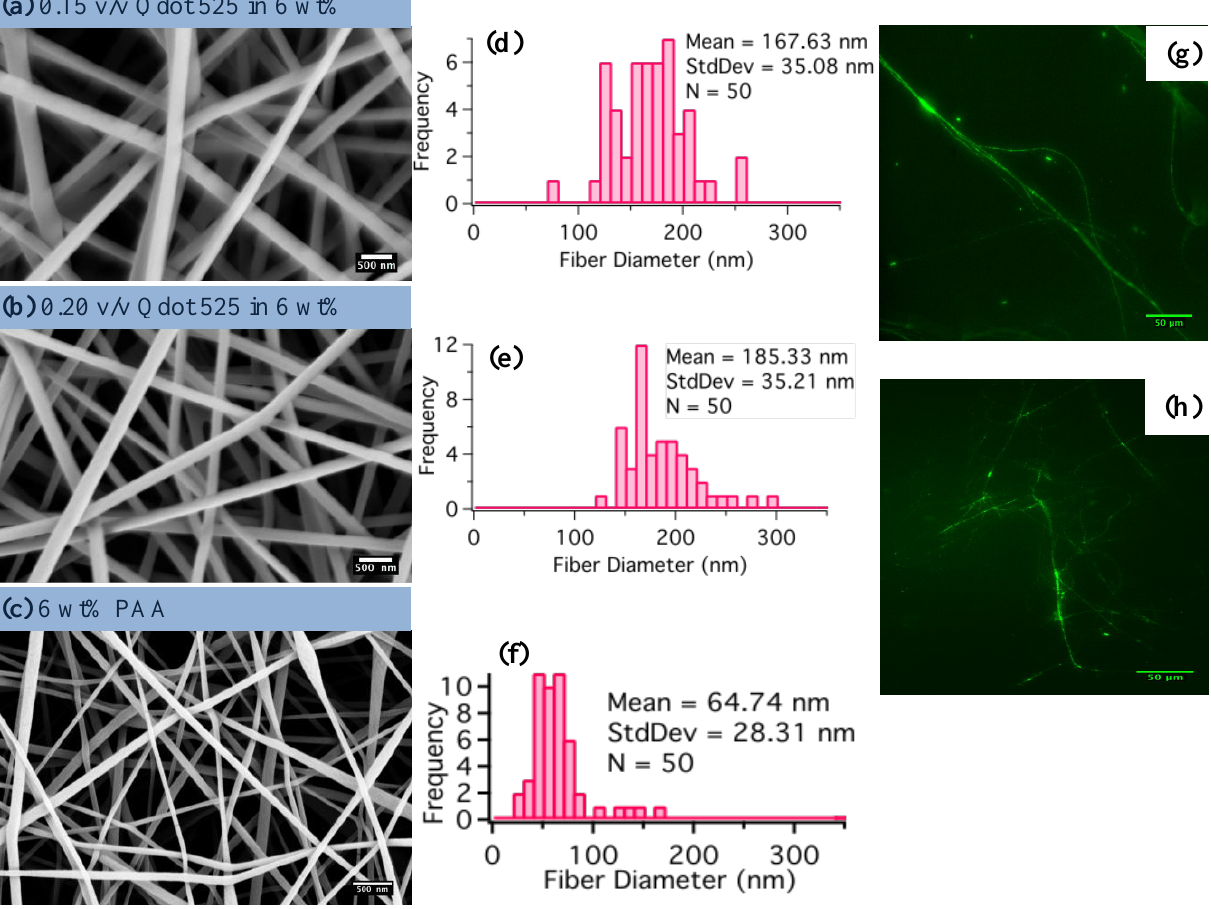
Figure 2. Composite fiber characterization: The SEM micrographs display smooth uniform diameter fibers for the composite fibers (a,b) and pristine fibers (c) . The mean fiber diameters for both composite populations (d,e) are within one standard deviation. The pristine fibers (f) are nanoscale but have spindle like defects. The composite fibers (g,h) are fluorescent as shown in the false colored fluorescence micrographs. (SEM scale bar = 500 nm and fluorescence micrograph scale bar = 50 μm).